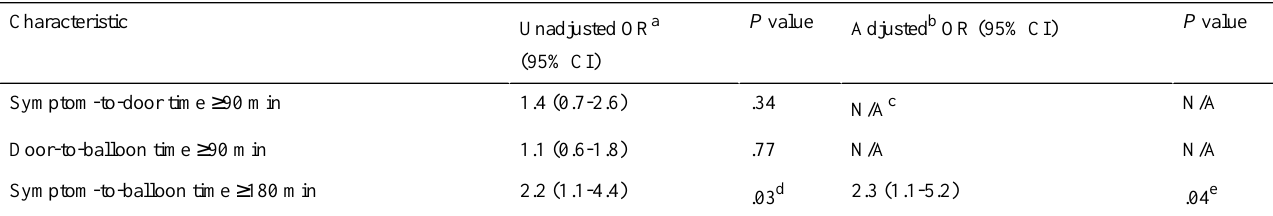
Table 2. Univariate and multivariate analyses of time to treatment and in-hospital major adverse cardiocerebrovascular events.